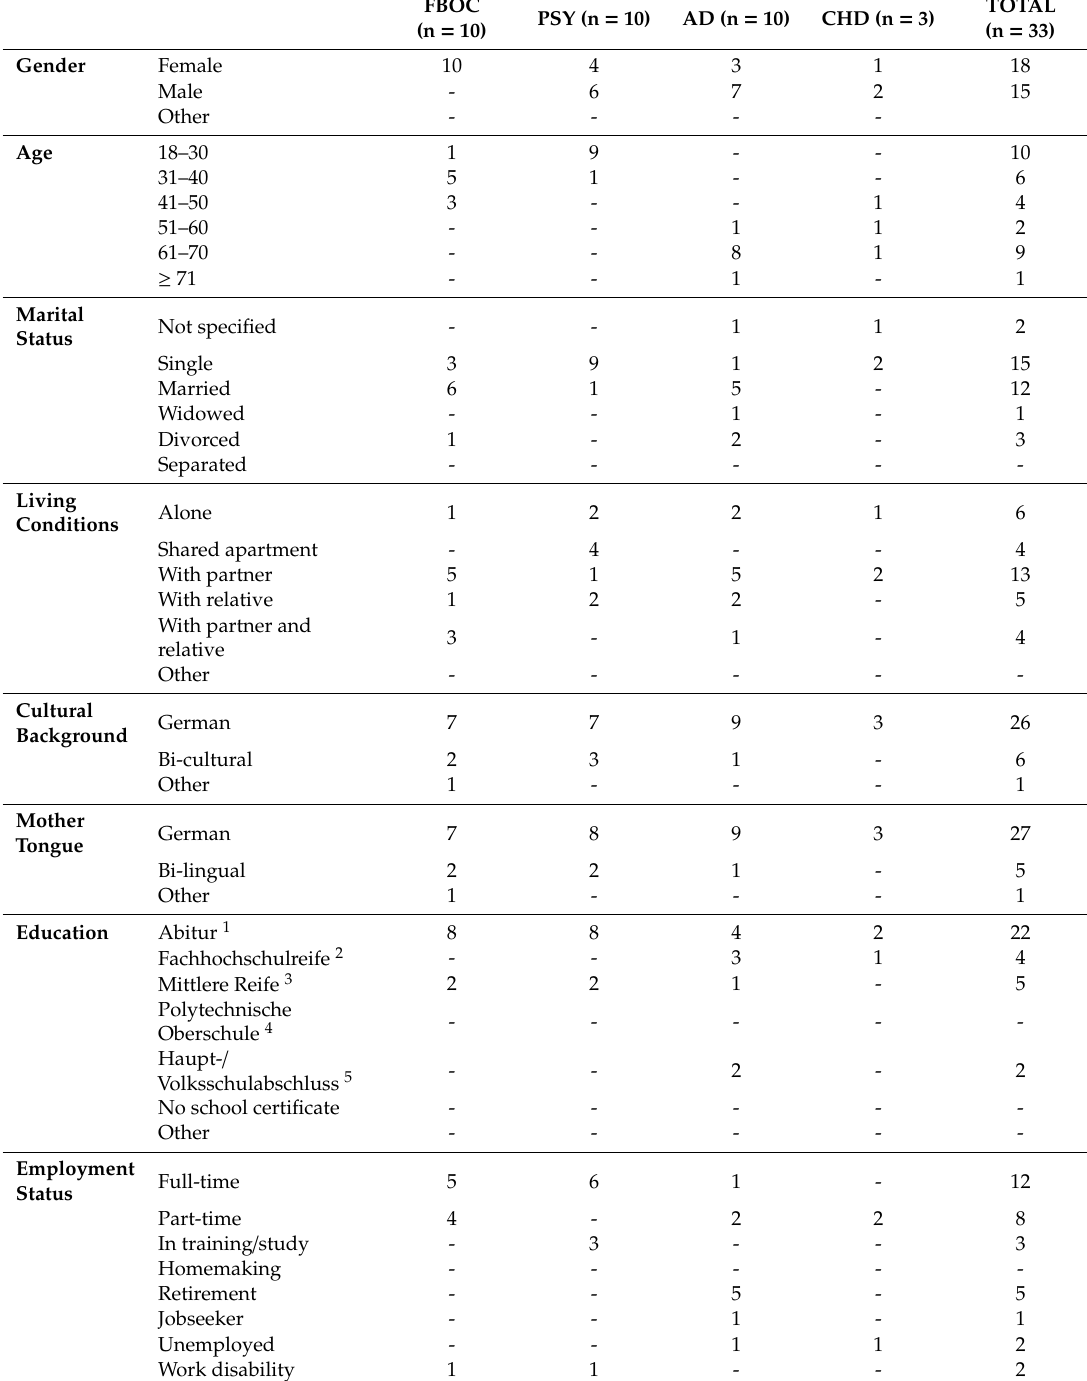
Table A3. Sociodemographic sample description per clinical